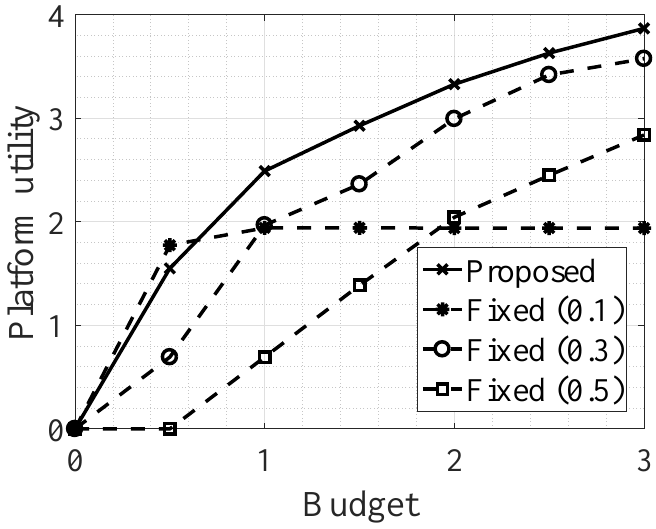
Figure 5. System utility vs. monetary budget.